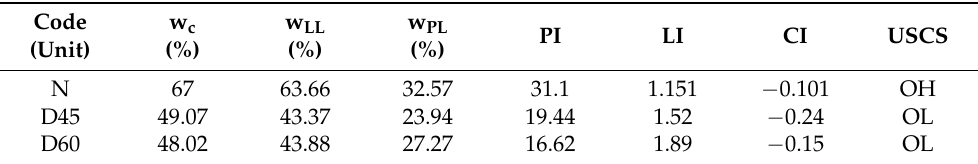
Table 4. Atterberg limits and soil classification for untreated soil (N) and treated distances of 450 mm (D45) and 600 mm (D60).